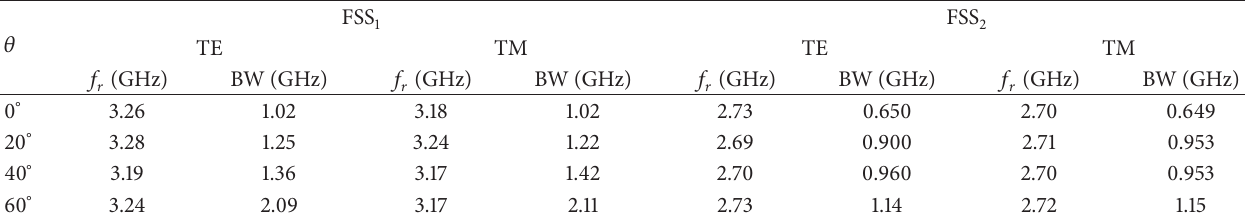
Figure 9: Measured transmission coefficient concerning the plane wave incidence angle and TM polarization for the proposed FSS structures: (a) FSS 1 and (b) FSS 2 . Table 1: Measured results for FSS transmission coefficient frequency behaviors concerning the plane wave incidence angle and TE and TM